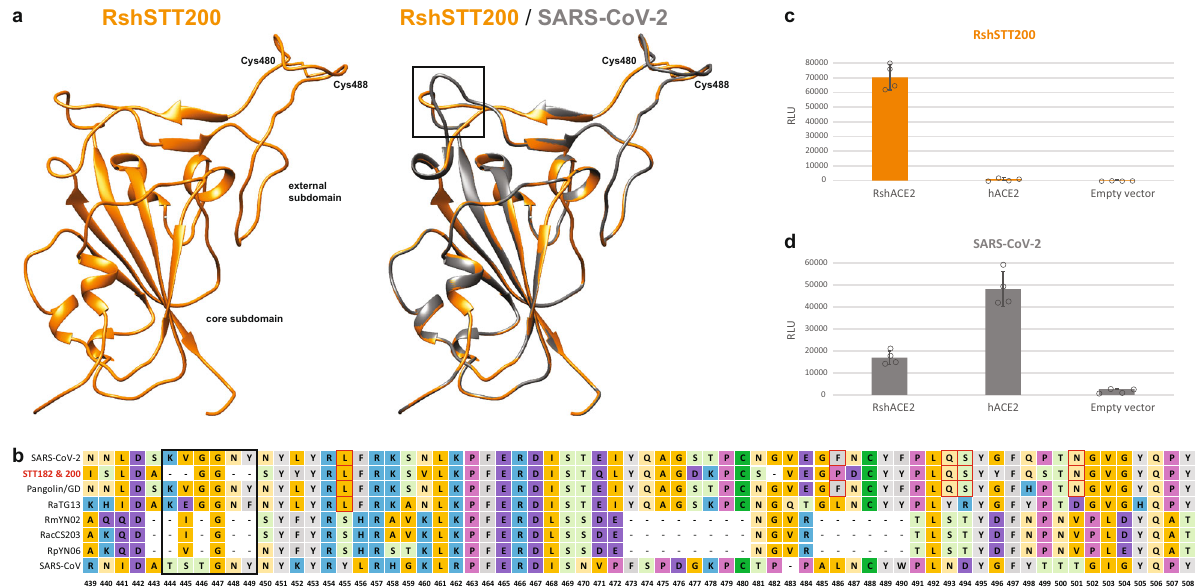
Fig. 3 Structural modeling. a Homology modeling of the RBD structure. The three-dimensional structure of the RshSTT200 Spike RBD was modeled using the Swiss-Model program employing the structure of SARS-CoV-2 (PDB: 6yla.1) as a template. The core and external subdomains are colored orange, and gray for RshSTT200 and SARS-CoV-2, respectively. The shortening a loop near the receptor-binding site of RshSTT200 are indicated by a black rectangle. The cysteines involved in a conserved disul fi de bond are indicated. b Alignment of the receptor binding motif amino acid sequences of selected betaCoVs. c RshSTT200 spike (deleted for the last 21 amino acids) pseudovirus entry into HEK293T cells transfected with either RshACE2, hACE2 or an empty vector (pLenti-puro). d SARS-CoV-2 spike pseudovirus entry into HEK293T cells transfected with either RshACE2, hACE2 or an empty vector (pLenti-puro). Data are represented as mean ± standard deviation of technical replicates ( n = 4) and are representative of three independent experiments. Source data are provided as a Source Data fi Recombination analysis . We used a combination of six methods implemented in RDP5 35 (RDP, GENECONV, MaxChi, Bootscan, SisScan, and 3SEQ) to detect potential recombination events, and conservatively considered recombination signal detected by at least fi ve methods. The beginning and end of breakpoints identi fi ed with RDP5 were used to split the genome into regions for further phylogenetic analysis. Phylogenetic analysis . Maximum-likelihood (ML) phylogenies were inferred using IQ-TREE v2.0.6 36 and branch support was calculated using ultrafast boot- strap approximation with 1000 replicates 37 . Prior to the tree reconstruction, the ModelFinder application 38 , as implemented in IQ-TREE, was used to select the best- fi tting nucleotide substitution model. Bayesian phylogenies were also inferred using MrBayes v3.2.7 39 , using the GTR substitution model. Ten million steps were run and parameters were sampled every 1000 steps. Structure modeling . The three-dimensional structure of the RBD of RshSTT200 was modeled using the SWISS-MODEL program 40 , using SARS-CoV-2 (PDB: 6yla.1) structure as it was the best hit for the RshSTT200 amino acid sequence input.